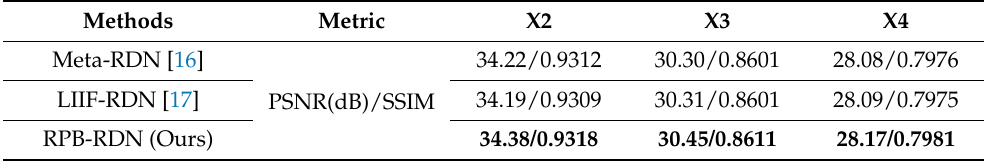
Table 4. The PSNR (dB) and SSIM performance in texture dataset Texture . The best performance is highlighted in the bold